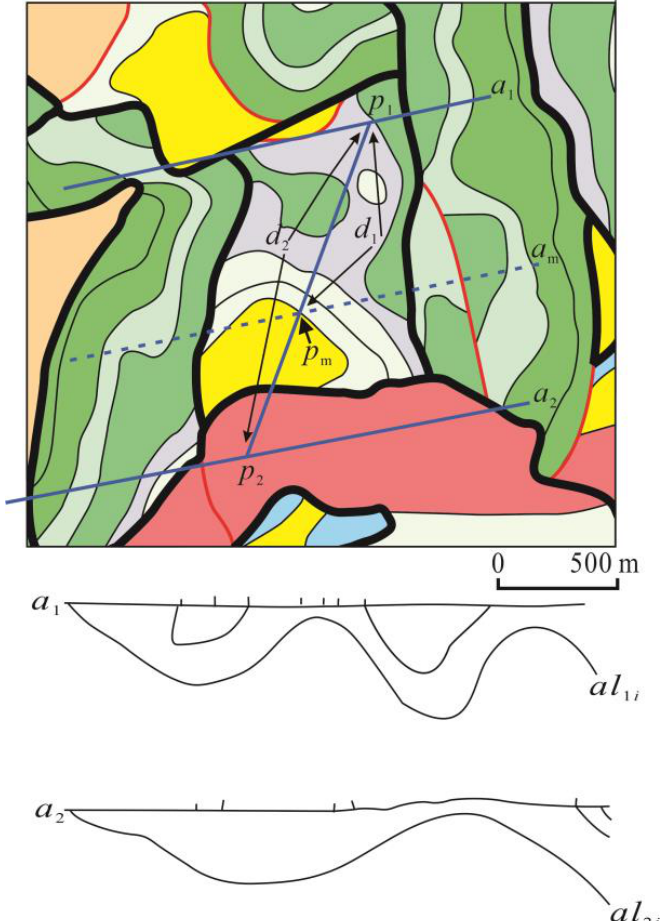
Figure 5. Section interpolation and parameters diagram.